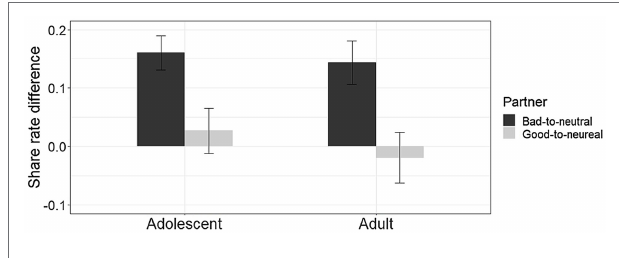
FIGURE 2 | The updating of share rates. The percentage difference of trials in which adolescents and adults shared on average between phase1 and phase2 separately to good-to-neutral and bad-to-neutral partner (error bars reflect